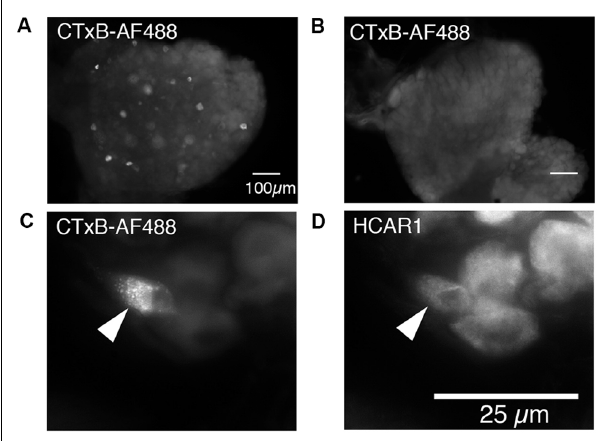
FIGURE 6 | Nerve cell bodies in T11 mouse dorsal root ganglia retrogradely labeled from abdominal muscles; immunohistochemical labeling for HCAR1. (A) Nerve cell bodies retrogradely labeled with CTxB-488 applied to the ipsilateral abdominal muscle group are shown in the dorsal root ganglion of T11. Panel (B) shows the contralateral ganglion which did not contain labeled neurons. (C) Intense CTxB-AF488 labeling in a single nerve cell body was immunoreactive for HCAR1 ( D